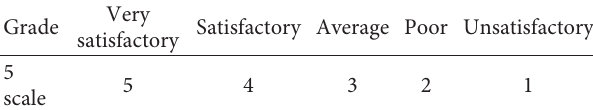
Table 1: Indicator evaluation table.